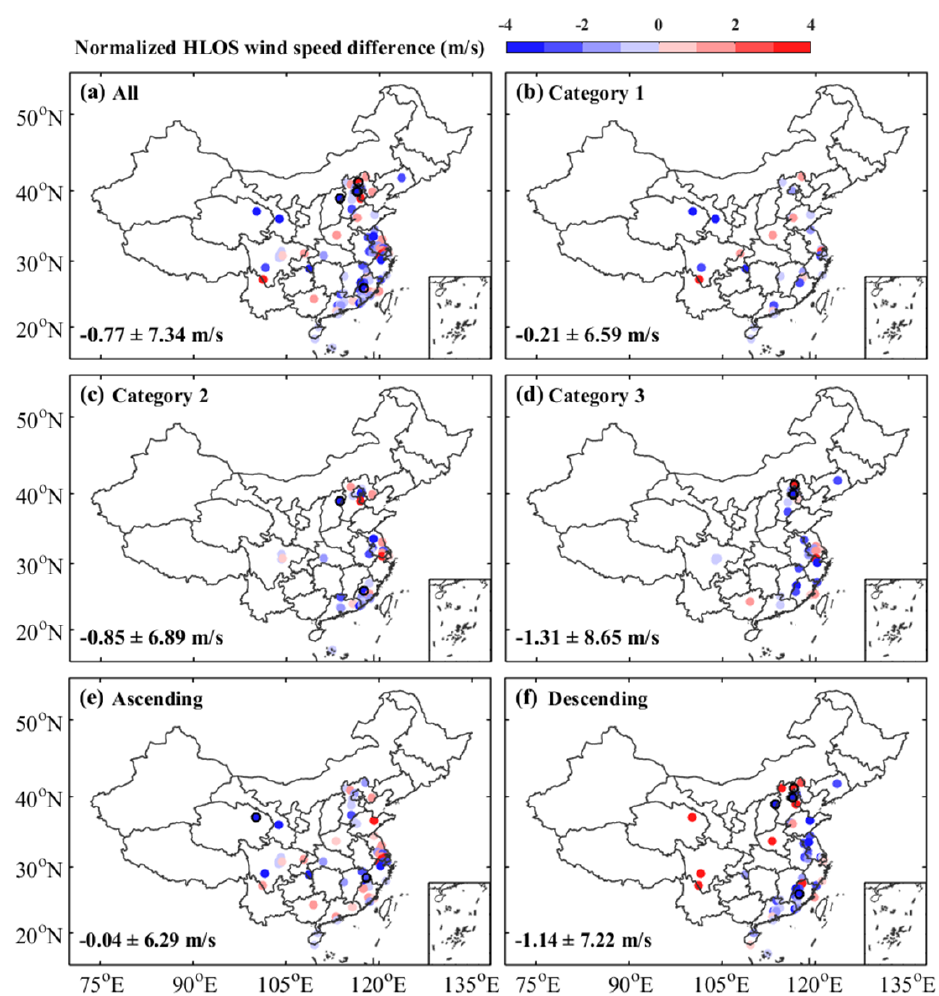
Figure 10. Same as Fig. 9 but for Rayleigh-clear